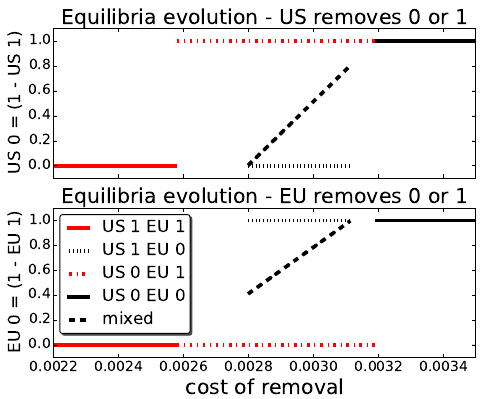
Figure 7. Equilibrium strategies for the sub-game {remove 0, remove 1} for a range of removal costs C r .